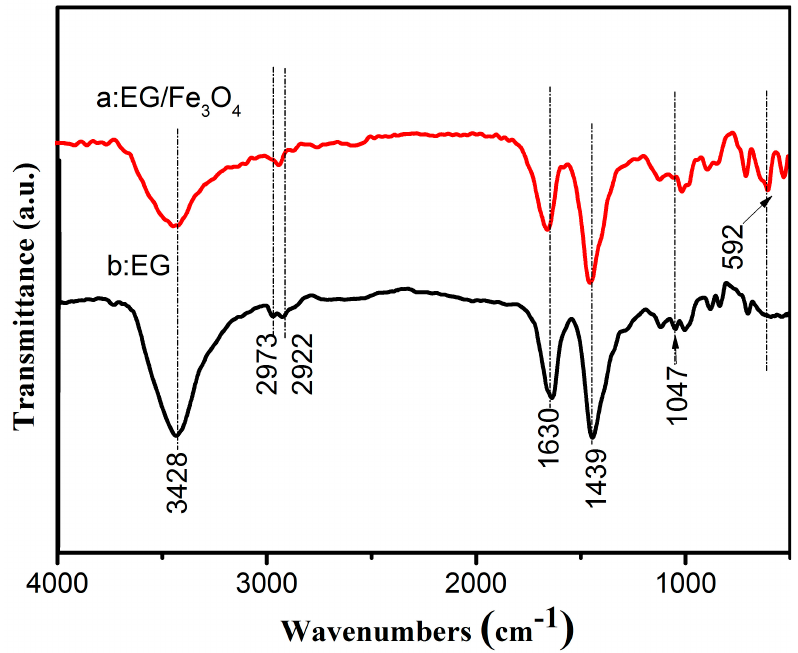
Figure 4. Fourier transform infrared (FT-IR) spectra of EG and EG/Fe 3 O 4 composites.